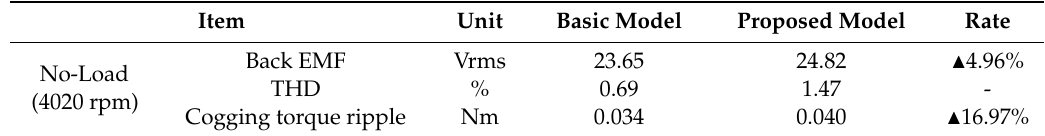
Table 5. Comparison of the characteristics at no-load.